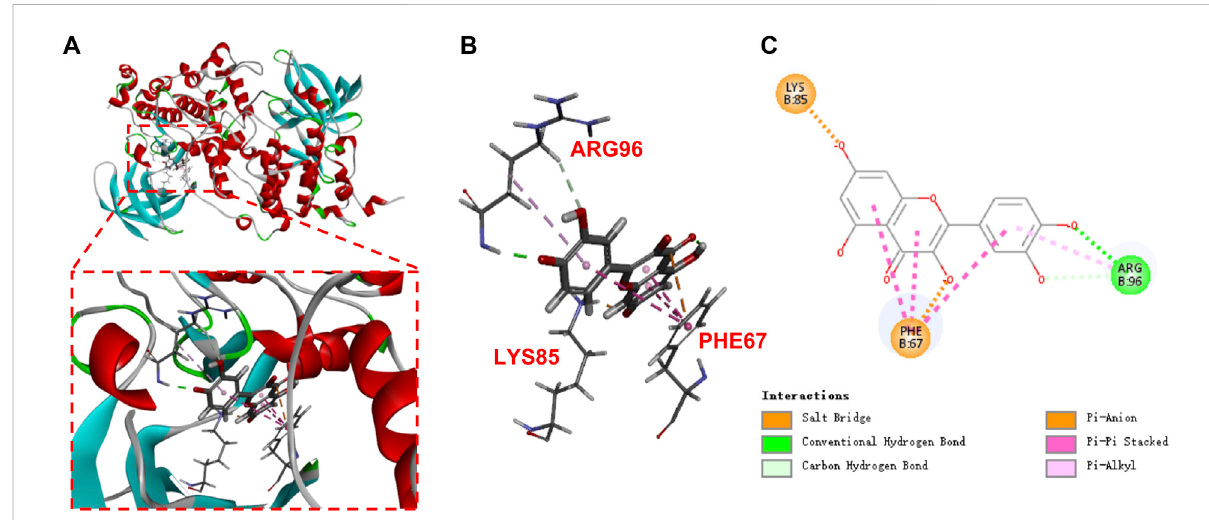
FIGURE 5 Molecular docking of quercetin (A,B) , 3D; (C) , 2D in the binding pocket of GSK3 β